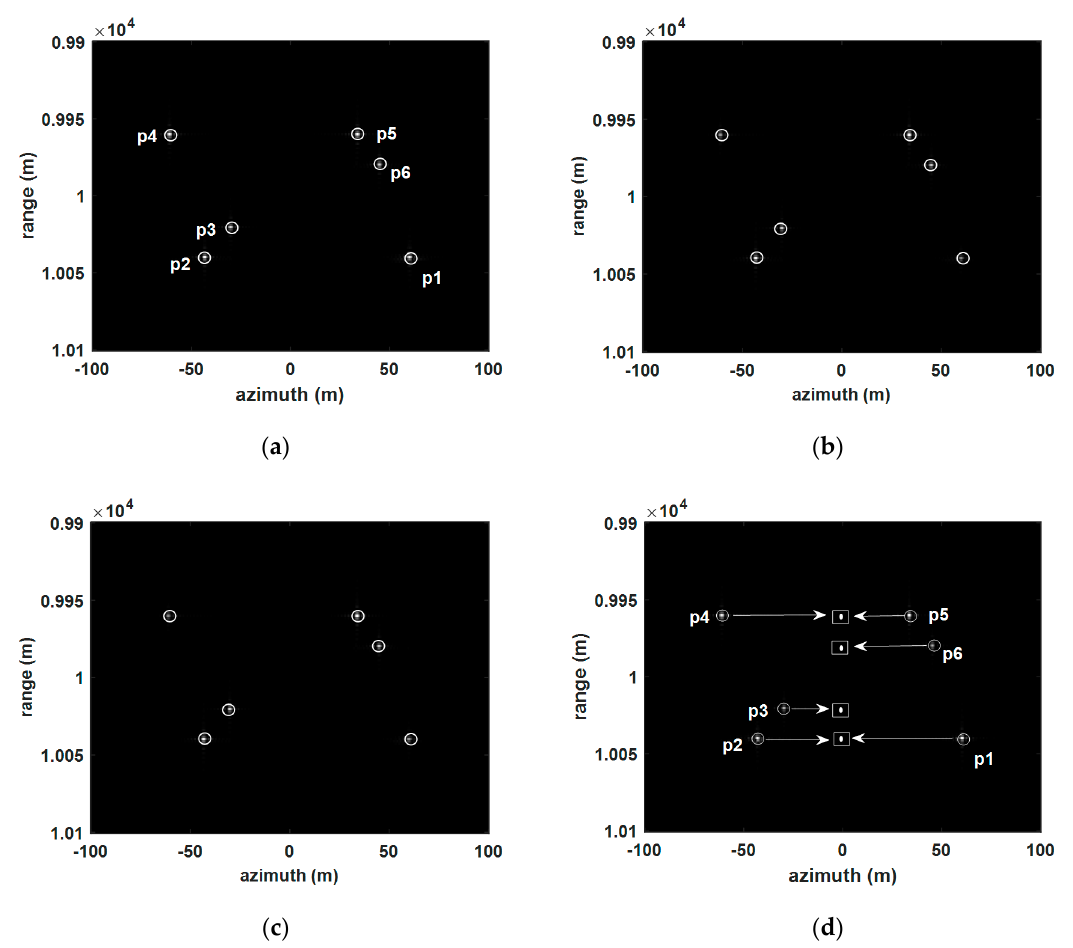
Figure 6. Simulations of false targets generated by one transponder. ( a ) is the SAR image of channel A 2 ; ( b ) is the result of the channel A 2 and A 3 DPCA operation; ( c ) is the result of the channel A 1 and A 2 DPCA operation; ( d ) is the relocation result.